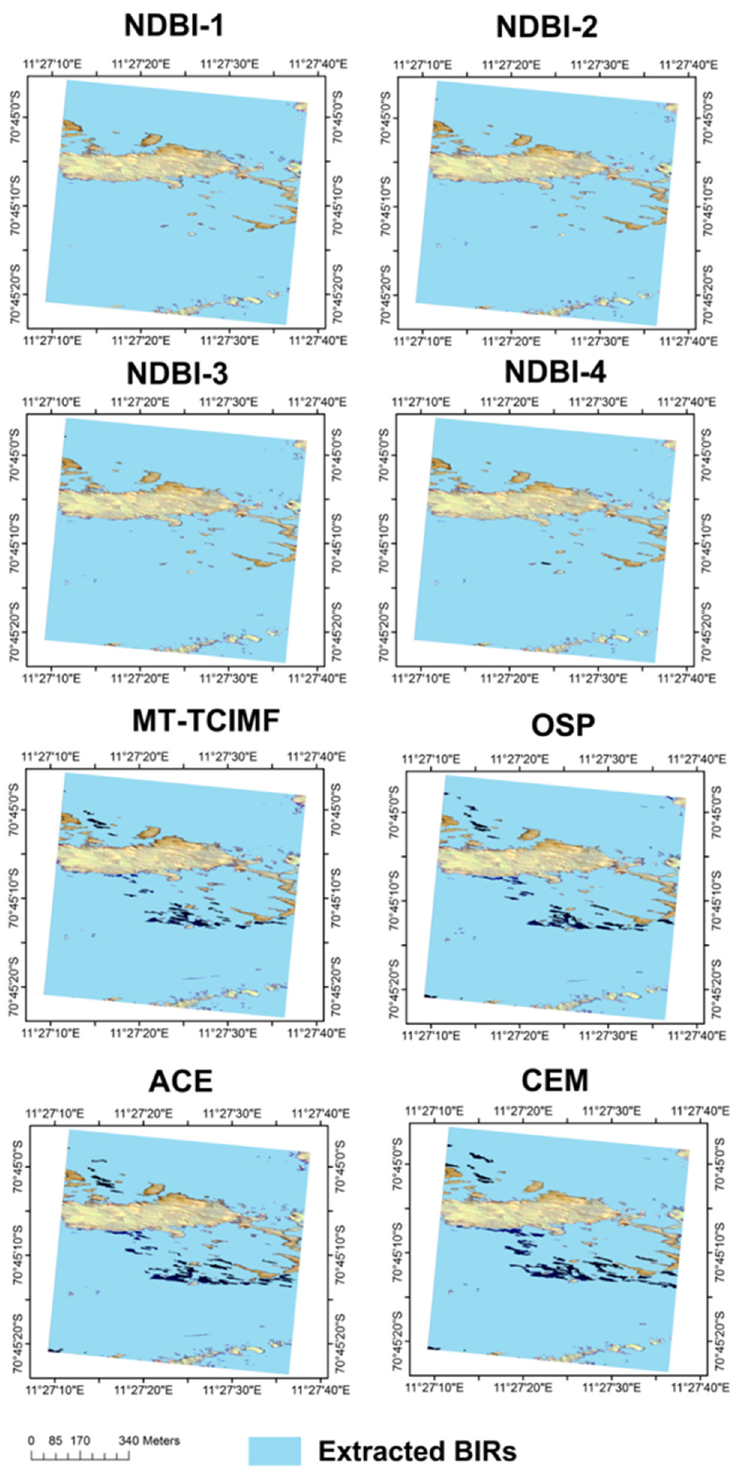
Figure 6. A visual image analysis of extracted BIRs from the sample Tile-1 using four NDBI meth- ods under the customized NDBI approach and four supervised target detection methods under TD approach. Extracted BIR patches are appended on the WorldView-2 image (RGB: 8,5,1 band combination). The dark blue patches visible on images are non-BIRs.